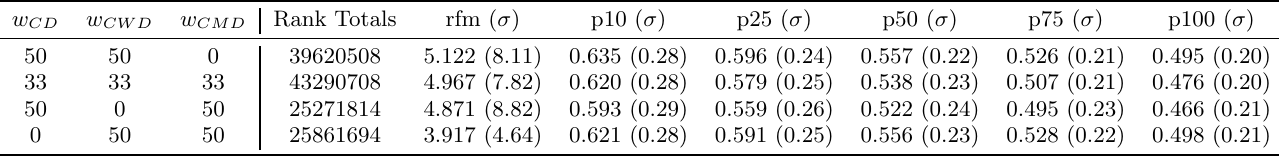
Table 6: Results excluding not connected days (Average per day and Standard Deviation)